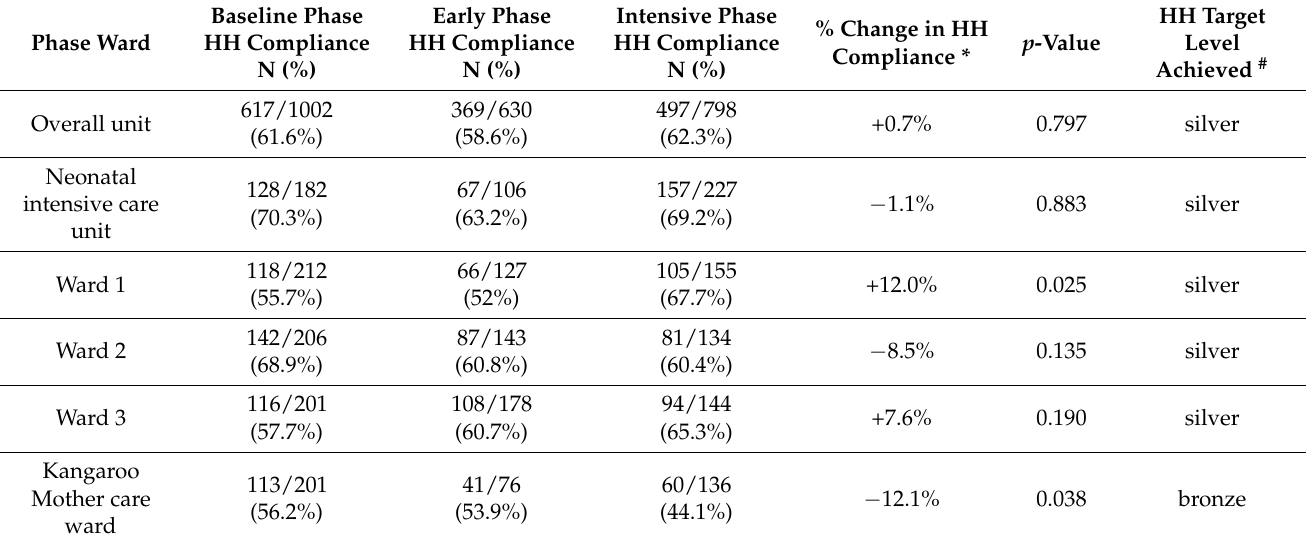
Table 1. Observed hand hygiene (HH) compliance rates by neonatal ward type and study